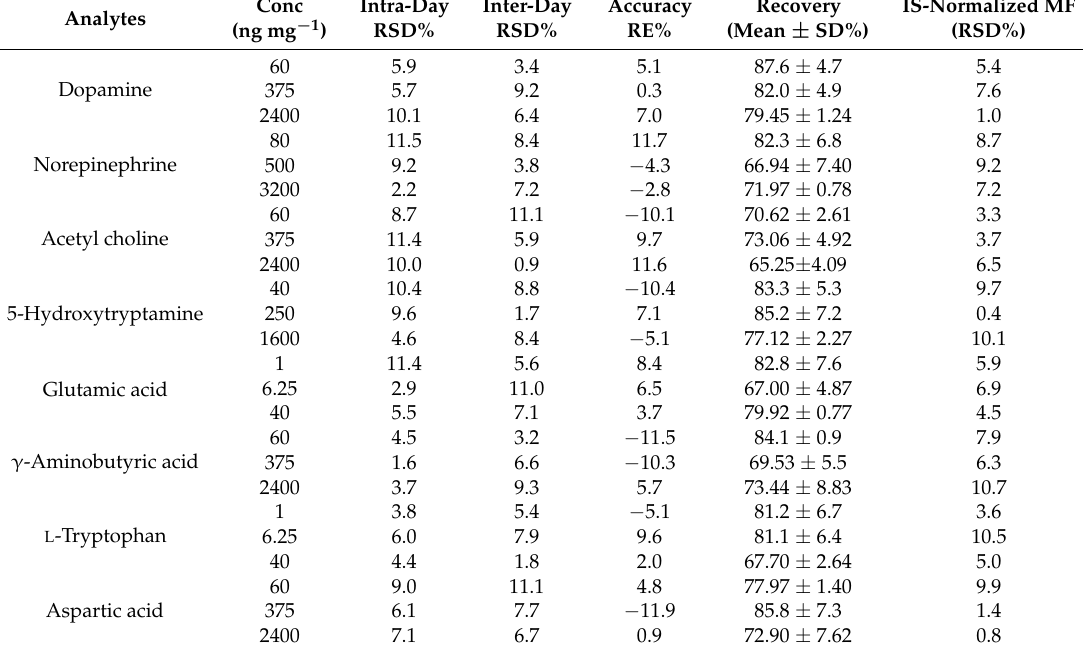
Table 3. Summary of accuracy, precision, recovery and matrix effect in rat brain (n =